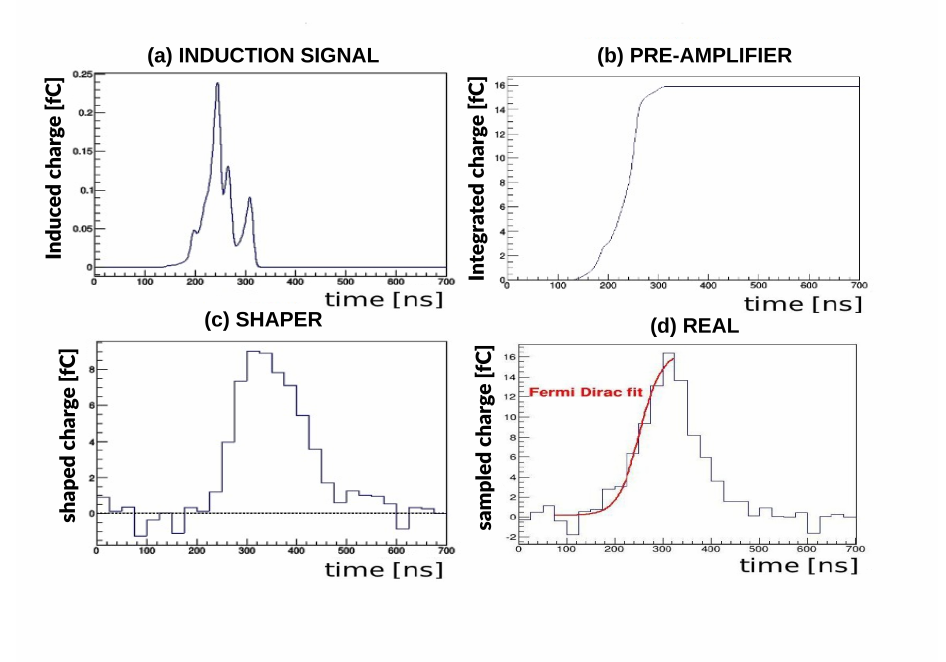
Figure 4: Top left: induced current on a single strip in a single particle simulation. Top right: shape of the current after the pre-amplifier simulation on a single strip. Bottom left: shape of the current after a shaper simulation with a RC-CR circuit having an integration time of 50 ns. Bottom right: example of the signal measured by a real event from an experimental setup to be compared with the previous